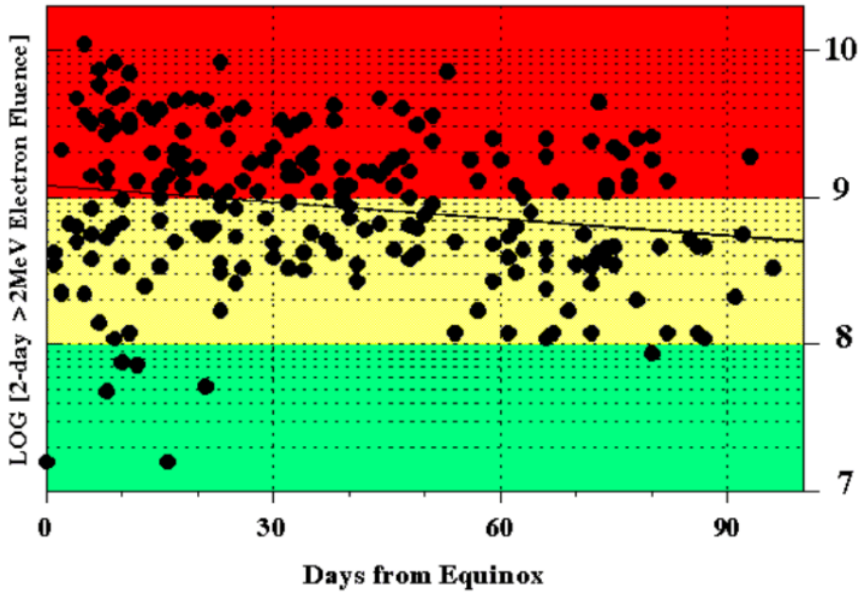
Fig. 3. Distribution of switches with respect to 2-day > 2MeV electron fluence and to number of days from equinox.